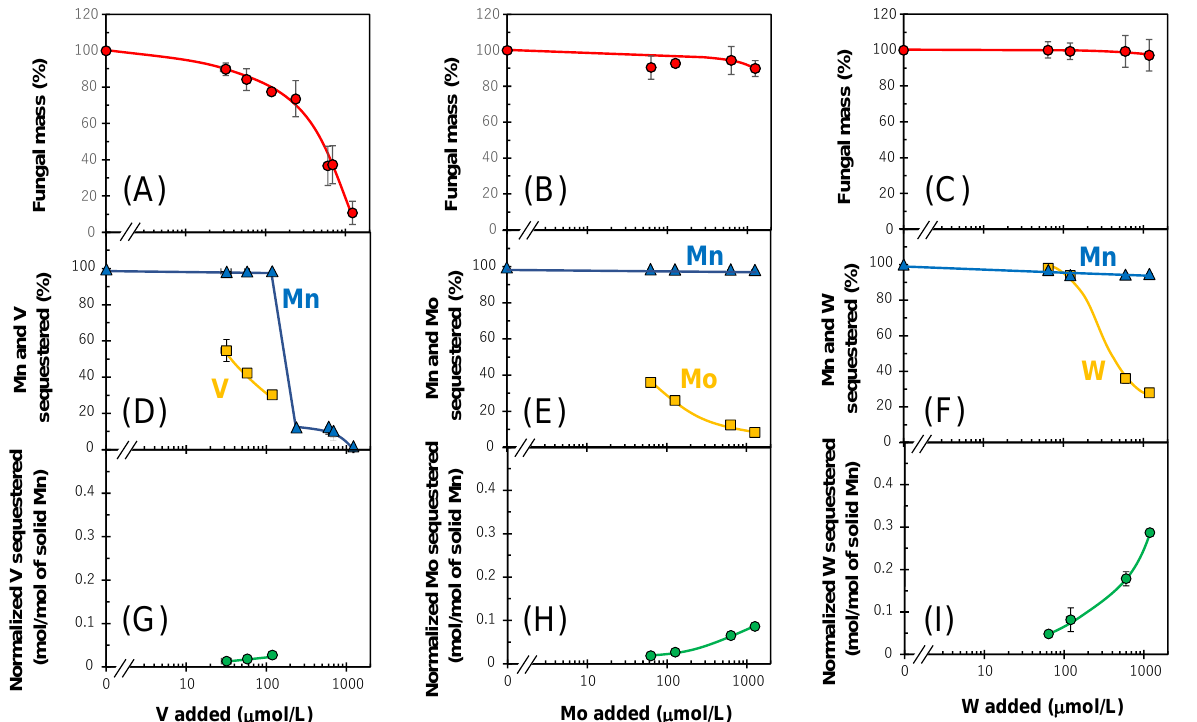
Figure 2. Effects of coexisting ( A , D , G ) V(V), ( B , E , H ) Mo(VI), and ( C , F , I ) W(VI) on: ( A – C ) growth, ( D – F ) Mn(II) oxidizing ability, and ( G – I ) subsequent sequestration ability for oxyanions during the incubation of Acremonium strictum KR21-2 in HAY liquid media (20 mM HEPES buffer at pH